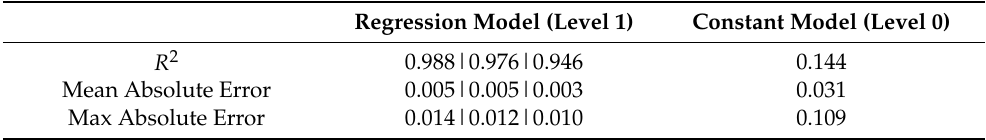
Table 7. Comparing Regression Model and Constant Model Performances on the Test Data (75–76 data points) for each sub-data set P in , rel ∈ [ 0.1,0.334 ] | ( 0.334,0.668 ] | ( 0.668,1 ] . For the constant model evaluation, the mean efficiency value of all three training data sets and the metrics for all three test data sets were computed.